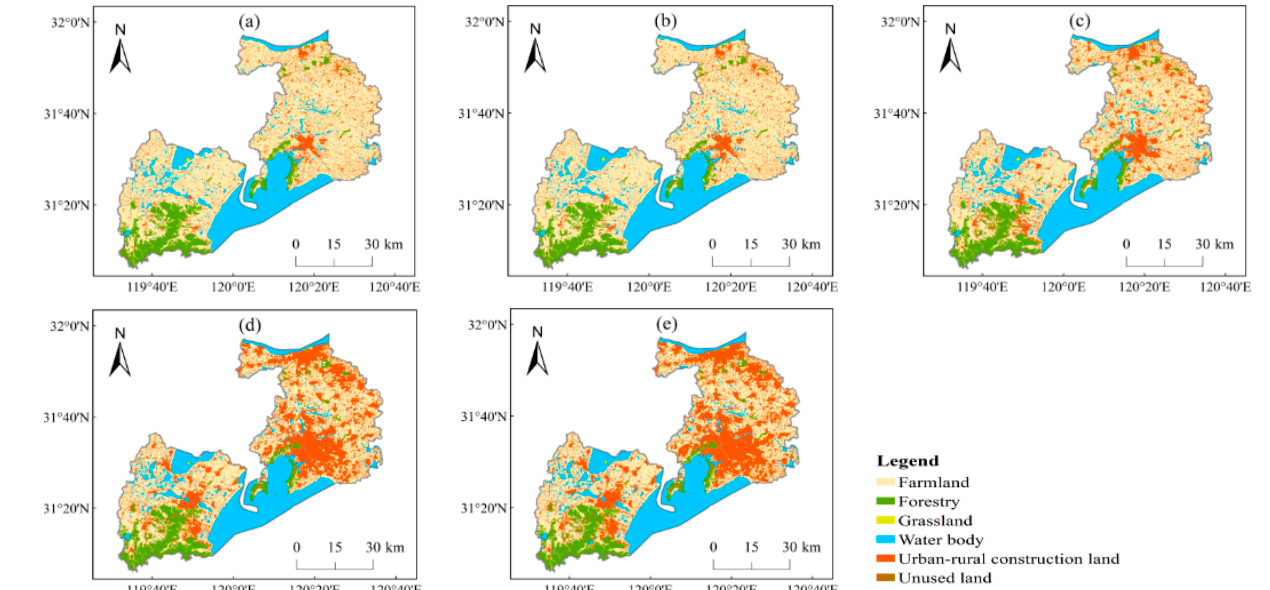
Figure 7. Changes in land use types in Wuxi area from 1980 to 2020: 1980 ( a ), 1990 ( b ), 2000 ( c ), 2010 ( d ), 2020 ( e ).